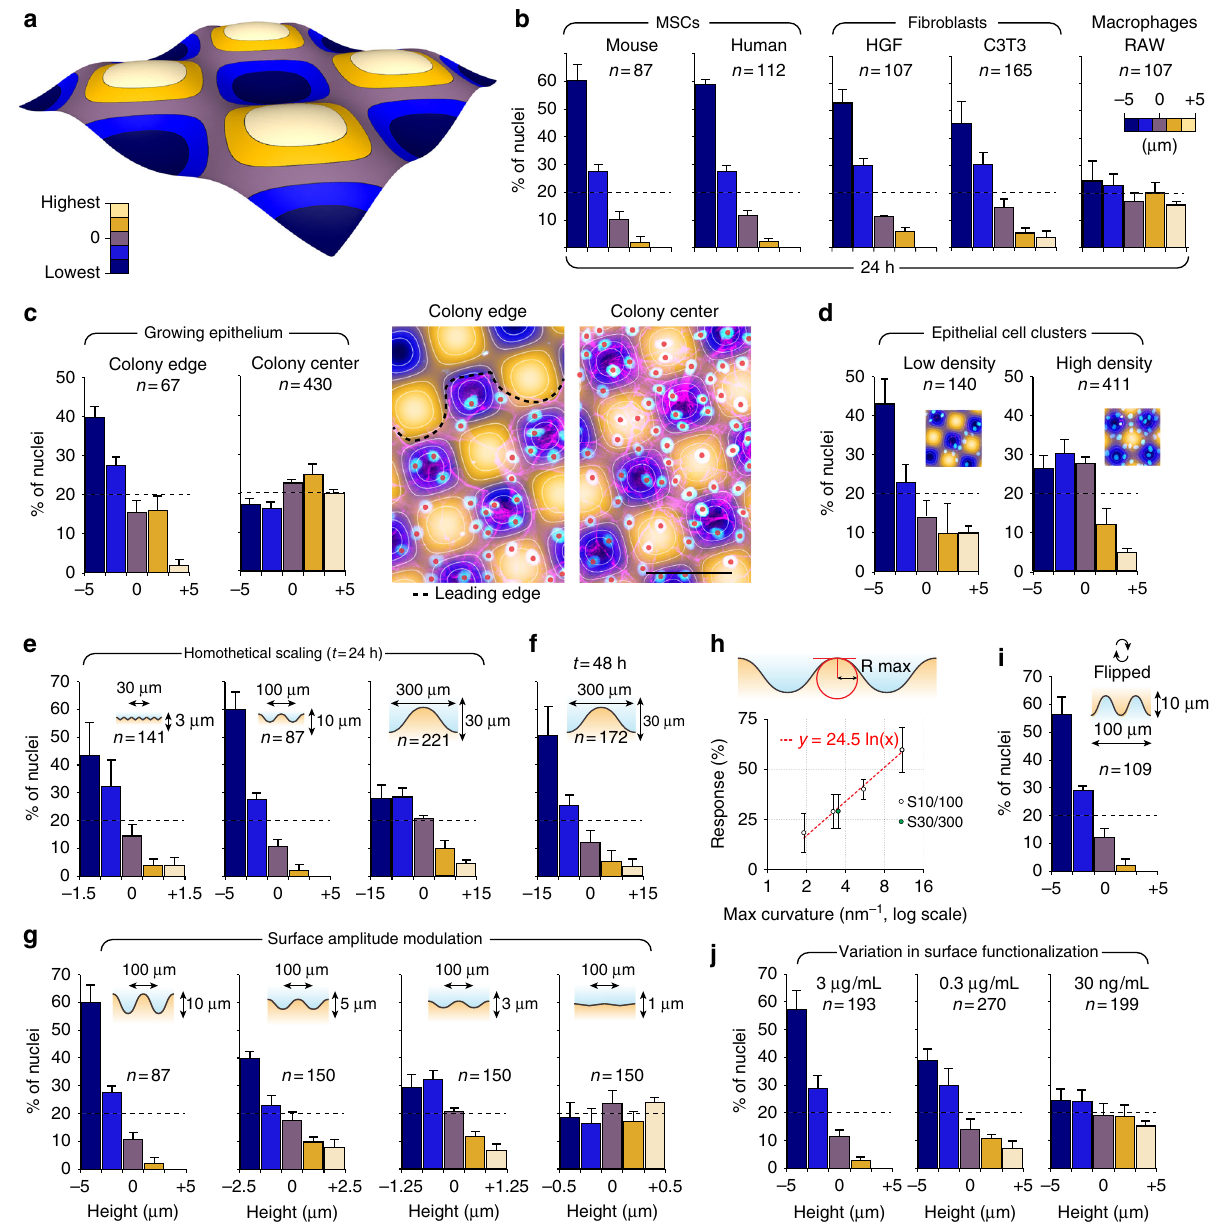
Fig. 2 Adherent cells position themselves in the concave areas of cell-scale hills-and-valleys landscapes. a The surfaces were segmented into fi ve areas delimited by isoheights contour lines. b Spatial distribution of different cell types assessed 24 h after surface inoculation on S10/100 surfaces. c , d Spatial distribution of MDCK cells within an epithelium ( c ) or forming small clusters ( d ). For the epithelium, the edge is compared with the center of the colony. e – g Surface distribution of mMSCs on homothetically scaled surfaces ( e , f ) and a surface series of decreasing amplitude ( g ). h A logarithmic relationship links the cell response, expressed in percentage of cells on concave, to the maximal curvature radius of the surface. i Cell response at 24 h when the surface has been fl ipped 2 h after cell adhesion. j Cell response on surfaces functionalized with decreasing concentrations of fi bronectin. Error bars represent the standard error of the mean number of cells observed in three independent experiments. The total number of cells is indicated for each condition. Scale